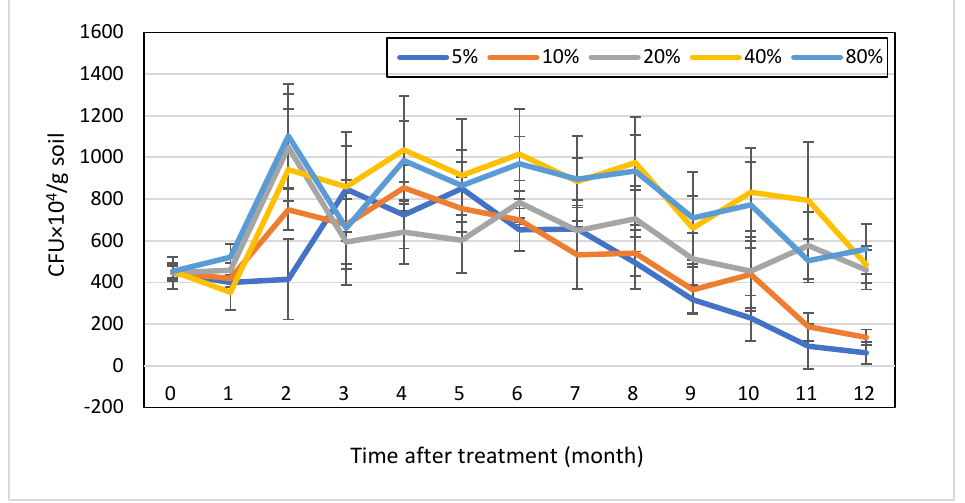
Figure 3. Survival dynamics of Trichoderma longibrachiatum Tr58 chlamydospores in soils with different moisture levels.